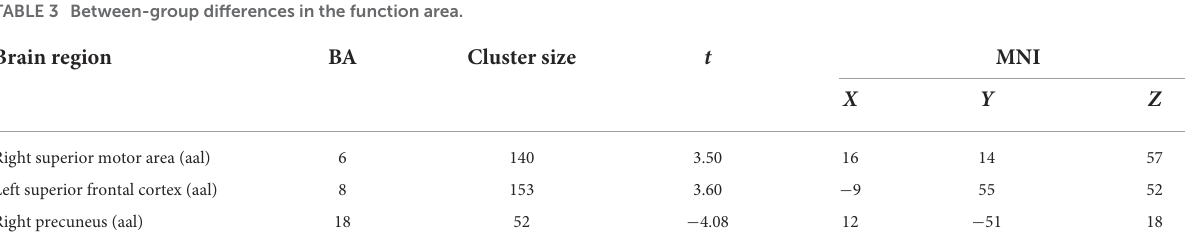
TABLE 3 Between-group differences in the function